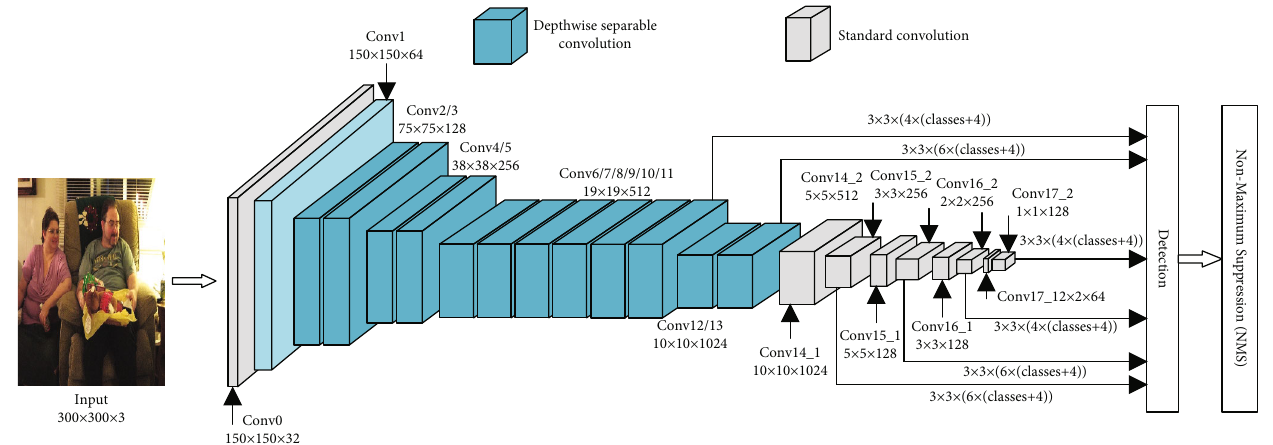
Figure 2: Network structure of